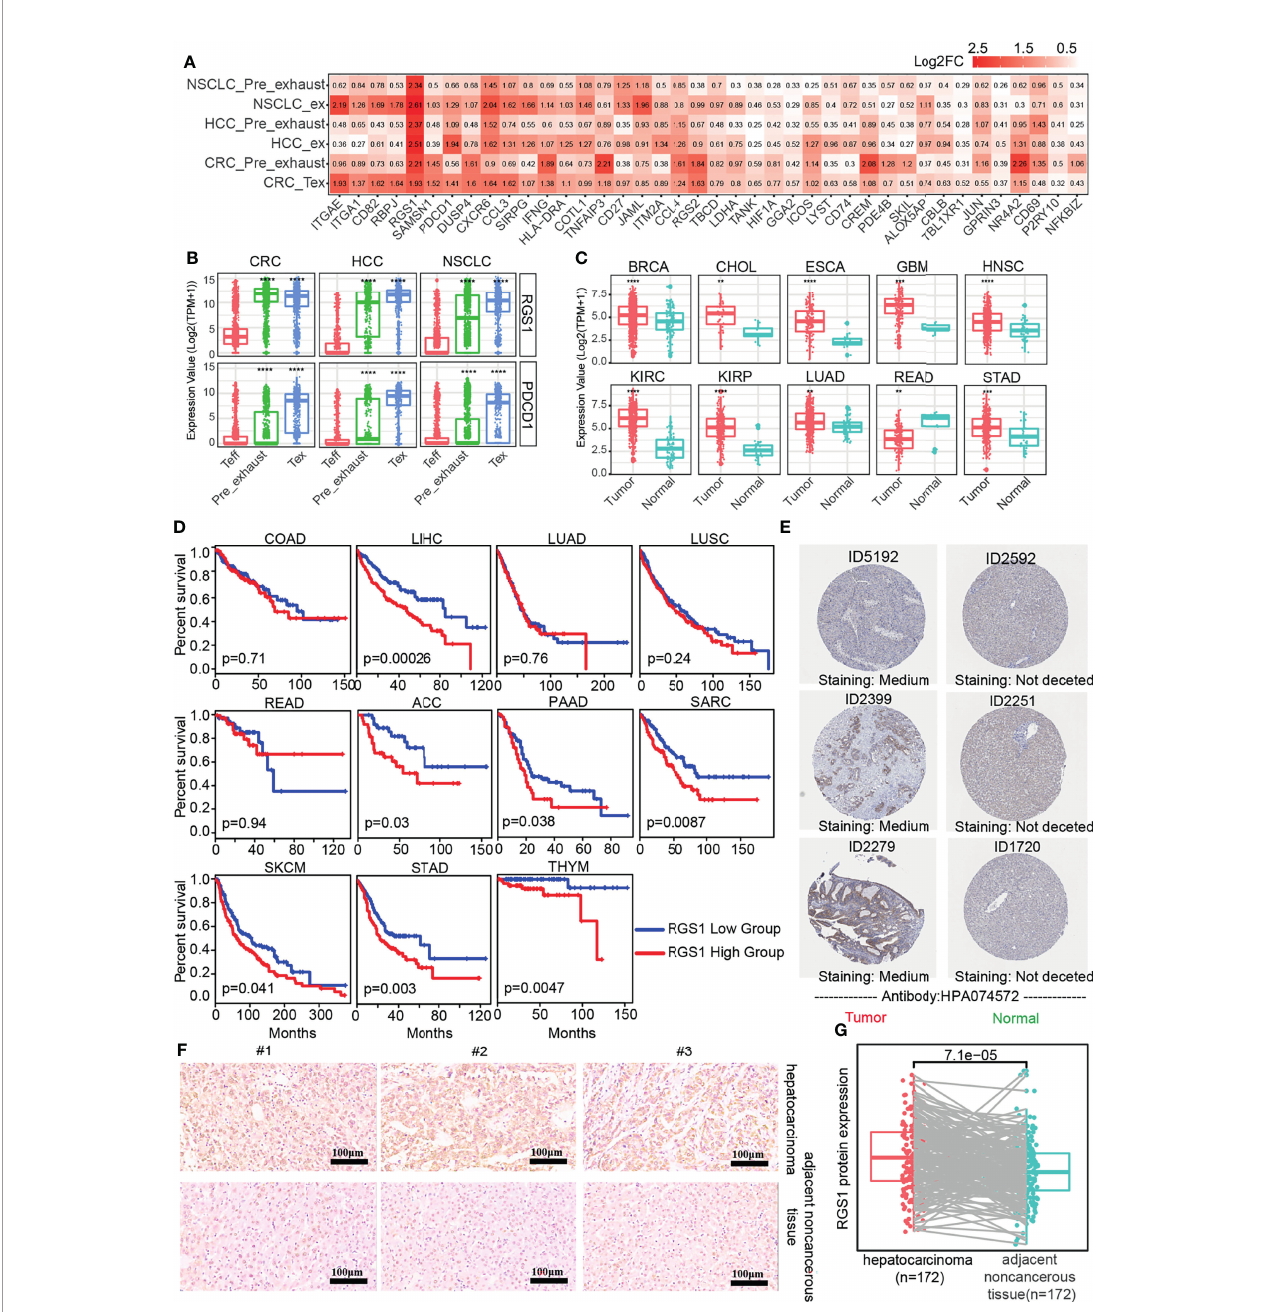
FIGURE 3 | DEGs in Pre_exhasuted and Tex cells compared with Teff cells. (A) The common upregulated genes in Pre_exhasuted and Tex cells compared with Teff cells. (B) The mRNA expression value of RGS1 in single-cell dataset and TCGA database (C) . (D) The Kaplan-Meier overall survival curves of TCGA patients grouped by the middle expression value of RGS1 . The red and blue lines denote higher and lower expression group, respectively. (E) Representative IHC images of RGS1 protein in tumor and normal tissues of liver derived from the HPA database and veri fi cation experiment ( F , scale bar 100 µm, magni fi cation ×20). (G) The protein expression value of RGS1 in hepatocarcinoma and adjacent noncancerous tissues in the IHC veri fi cation experiment. **p <= 0.01, ***p <= 0.001, ****p <=